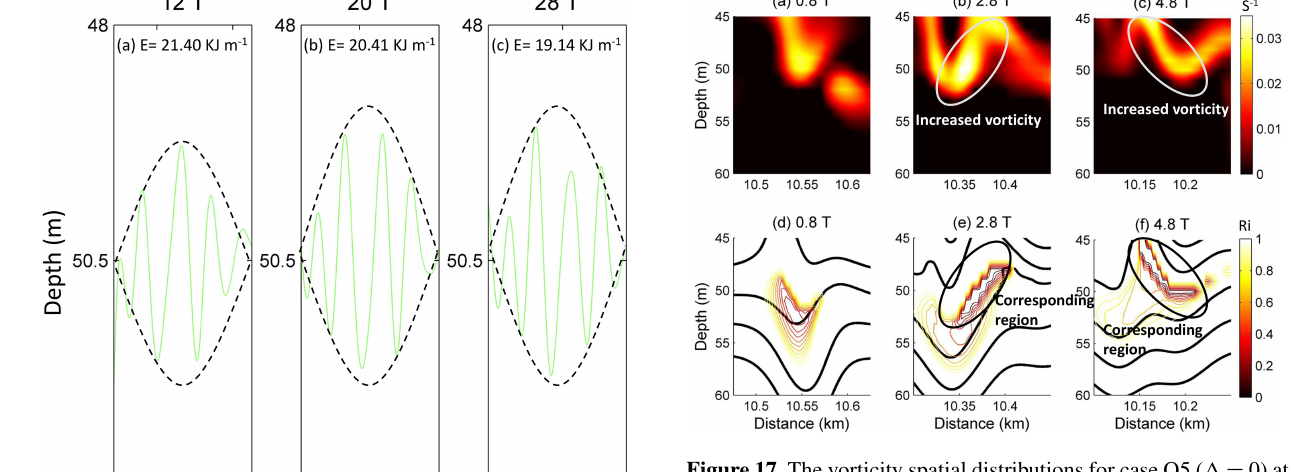
Figure 17. The vorticity spatial distributions for case O5 ( (cid:49) = 0) at (a) 0.8 T , (b) 2.8 T , (c) and 4.8 T , and the corresponding Ri values (ranges from 0 to 1) at (d) 0.8 T , (e) 2.8 T , and (f) 4.8 T .